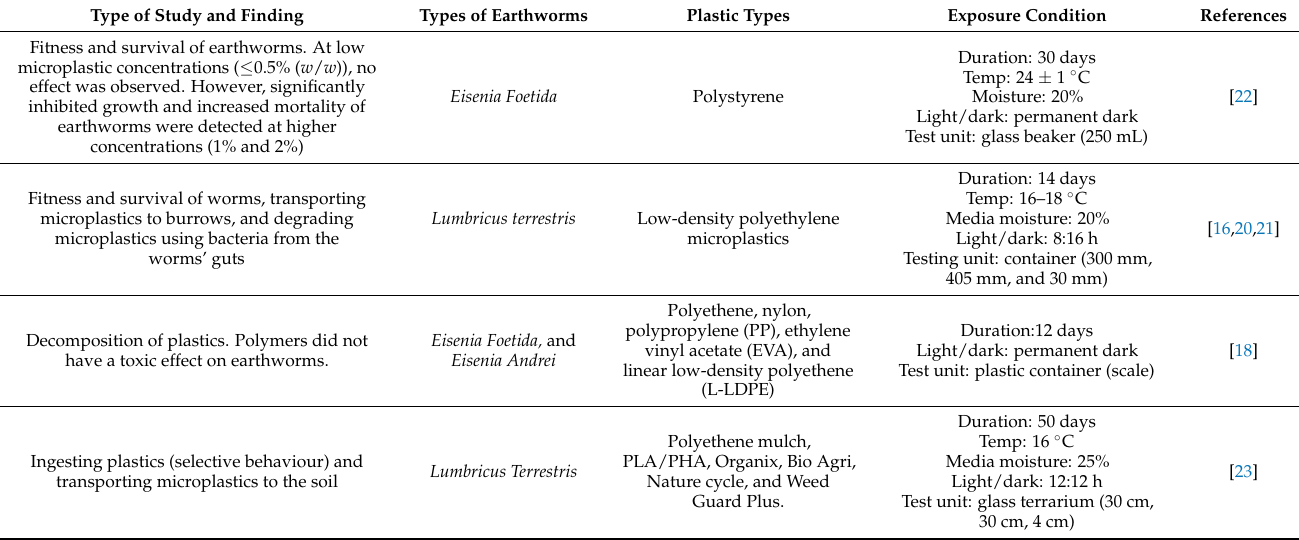
Table 1. Types of studies on earthworms and